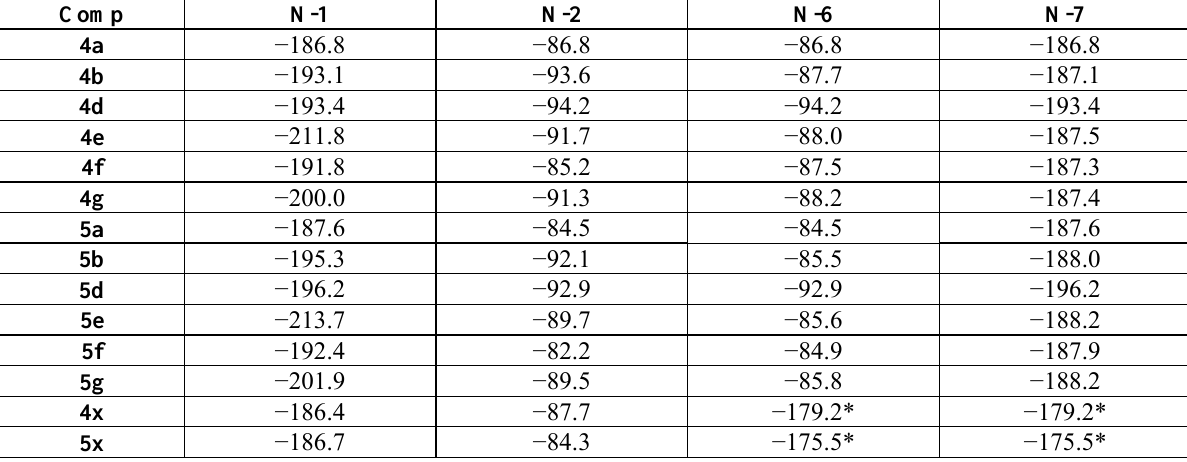
Table 5. 15 N-NMR chemical shifts of investigated compounds ( δ in ppm, solvents as listed in Table 2). Comp N-1 N-2 N-6 N-7 4a − 186.8 − 86.8 − 86.8 − 186.8 4b − 193.1 − 93.6 − 87.7 − 187.1 4d − 193.4 − 94.2 − 94.2 − 193.4 4e − 211.8 − 91.7 − 88.0 − 187.5 4f − 191.8 − 85.2 − 87.5 4g − 200.0 − 91.3 5b − 195.3 − 92.1 − 85.5 − 188.0 5d − 196.2 − 92.9 − 92.9 − 196.2 5e − 213.7 − 89.7 − 85.6 − 188.2 5f − 192.4 − 82.2 − 87.7 5x − 186.7 −